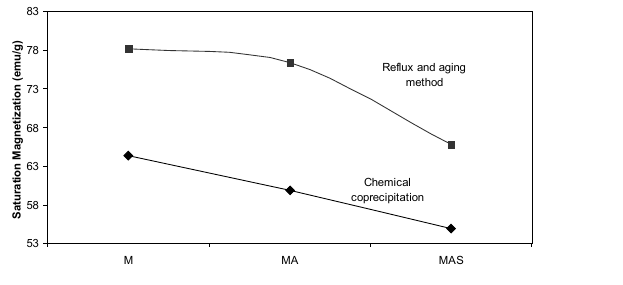
Figure 6. Dependence of protein adsorption on the amount of BSA added to the nanoparticles obtained by chemical coprecipitation and reflux and aging method.